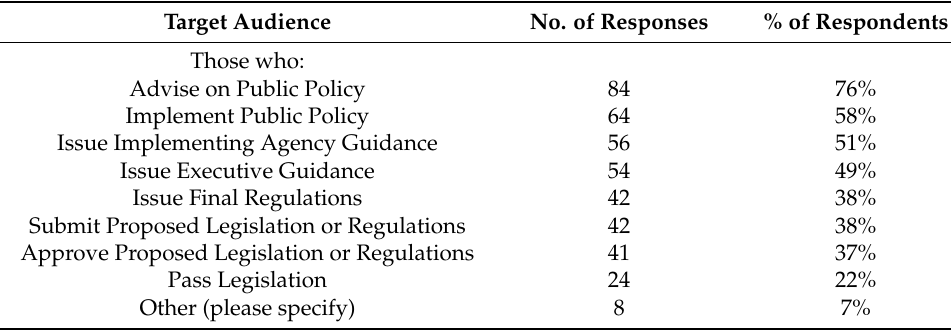
Table 6. Target audience for international guidance.